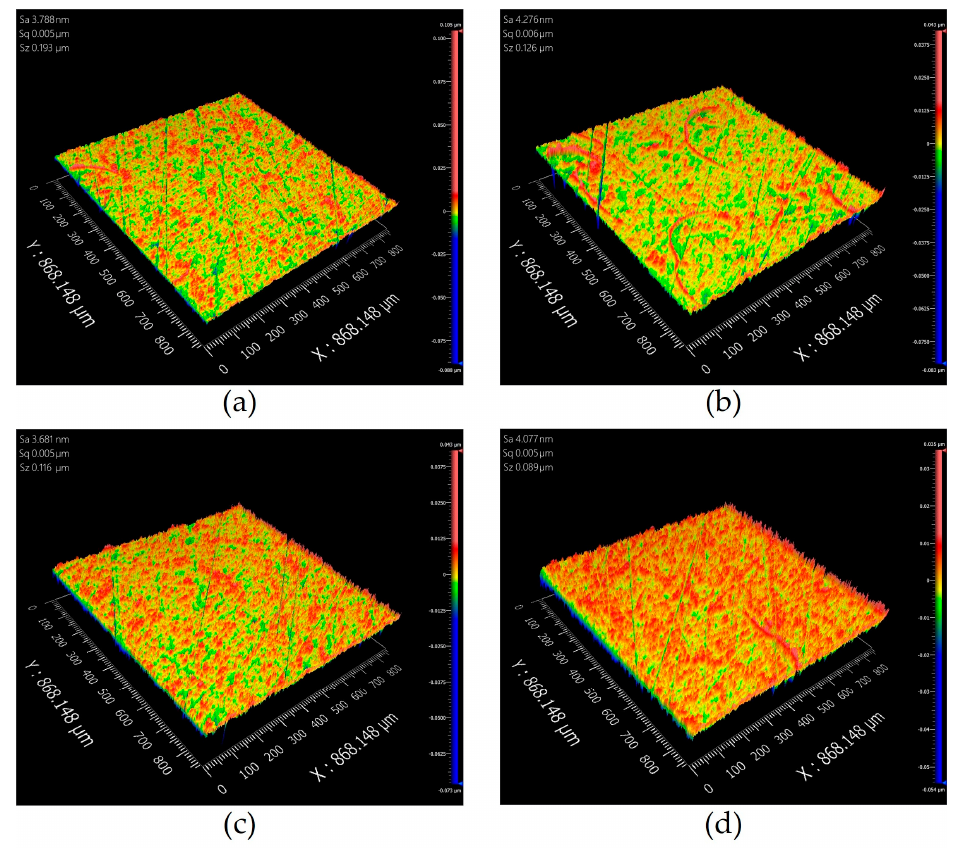
Figure 15. Surface roughness measurement results of four random areas of the complex curved plexiglass part.